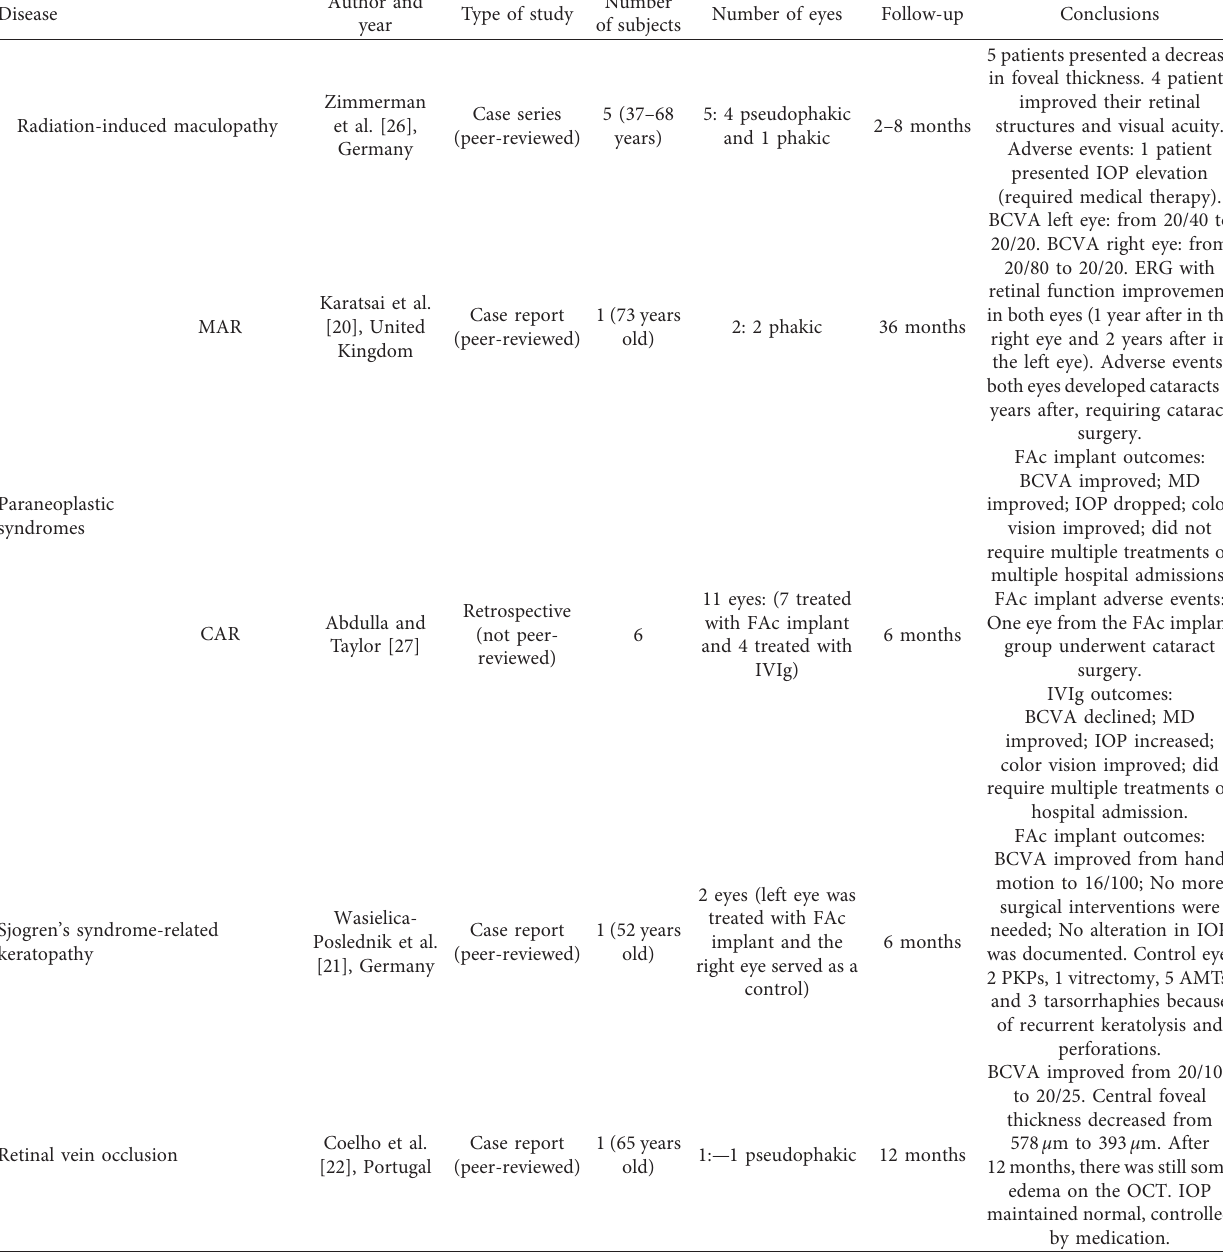
Table 1: Main characteristics of the included